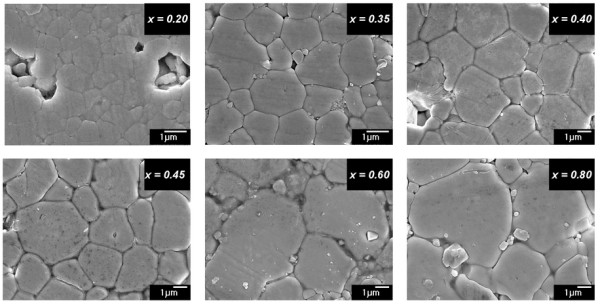
SEM image of Bi0.5Na0.5Ti1-xZrxO3 ceramics. Where x = 0.20, 0.35, 0.40, 0.45, 0.60, and 0.80 mole fraction.